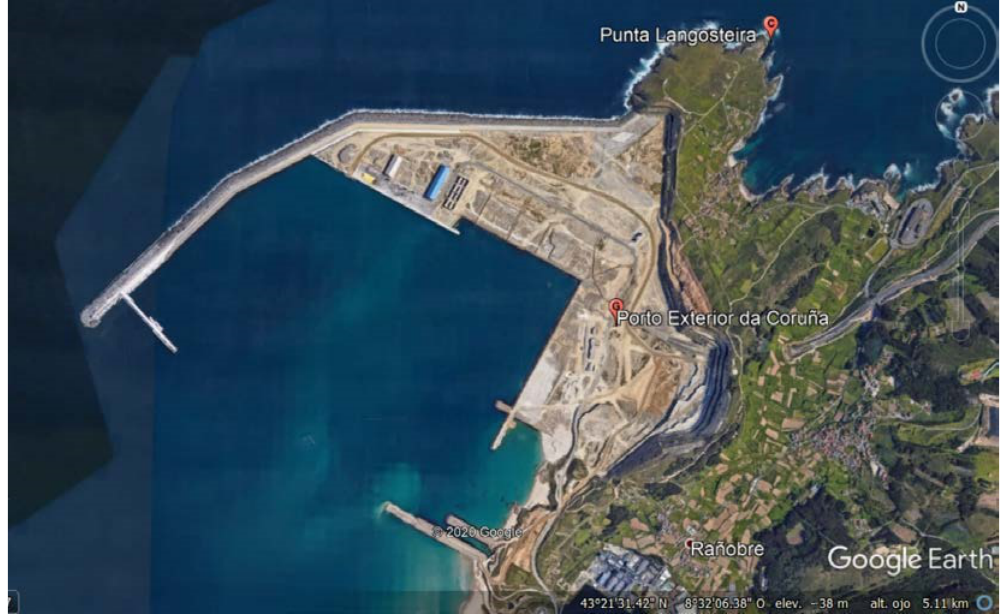
Figure 1. Outer Port of A Coruña “Langosteira” (Google Earth).